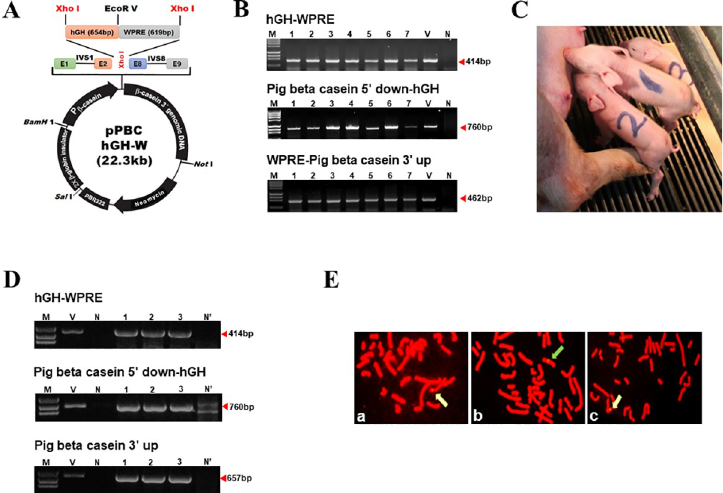
Fig 1. Production of human growth hormone transgenic pigs using SCNT. (A) Schematic of the pPBC-hGH-W vector. (B) Confirmation of transgene integration in transfected cells by PCR. M: size marker; V: pPBC-hGH-W vector as the positive control; N: Wild type PFF cells as the negative control; Lanes 1–7: porcine fetal fibroblasts transfected with pPBC-hGH-W constructs. (C) Identification of transgenic cloned rhGH-piglets. Three cloned transgenic pigs, 2 days after birth. (D) Identification of transgenic piglets by PCR using genomic DNA collected from piglets’ umbilical cords. Lanes 1–3 show the transgene detected in transgenic piglets. (E) Arrows indicate the localization of the rhGH gene in the cloned piglet chromosomes. a; Piglet 1, b; Piglet 2, c; Piglet 3 (from Panel C) 5 days after